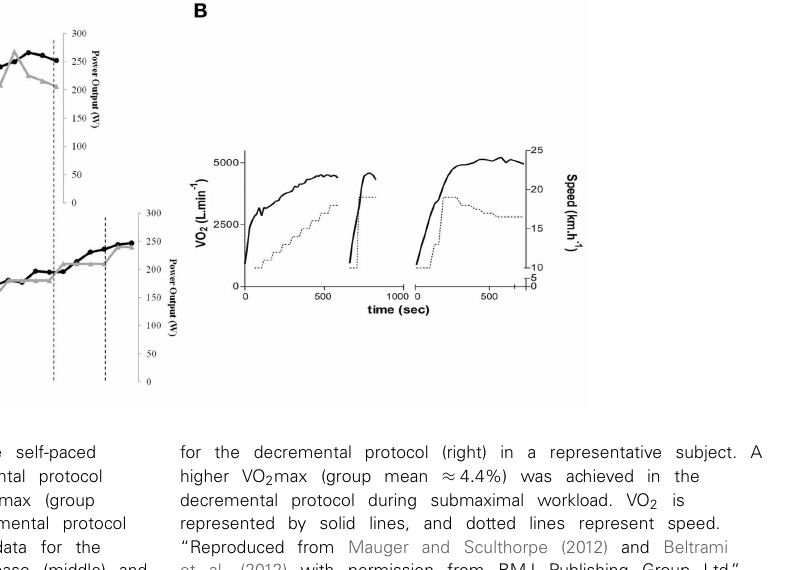
for the decremental protocol (right) in a representative subject. A higher VO 2 max (group mean ≈ 4 . 4%) was achieved in the decremental protocol during submaximal workload. VO 2 is represented by solid lines, and dotted lines represent speed. “Reproduced from Mauger and Sculthorpe (2012) and Beltrami et al. (2012) with permission from BMJ Publishing Group